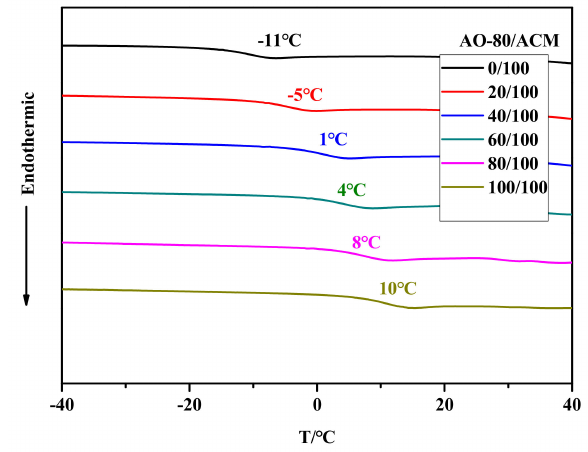
Figure 2. DSC curves of AO-80/acrylic rubber (ACM) rubber